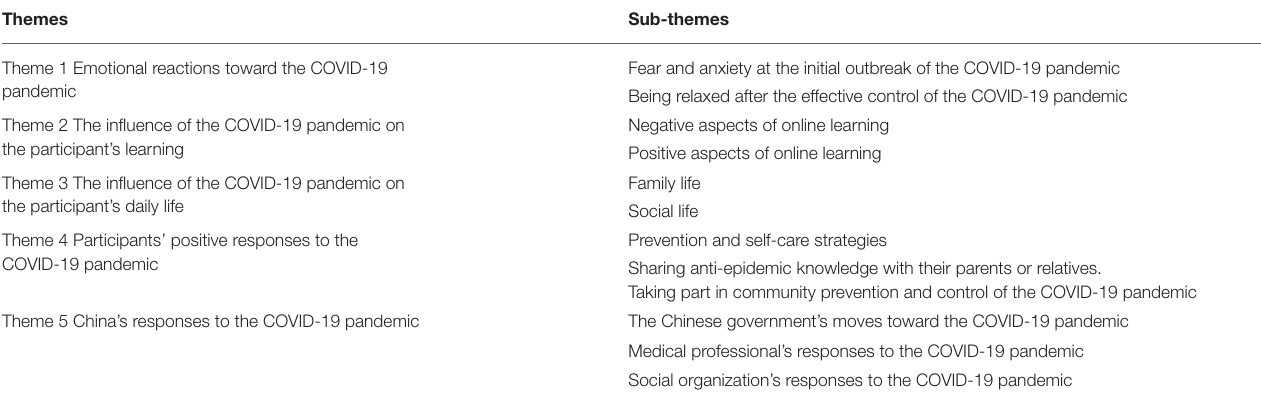
TABLE 2 | Results: five themes and 12 their sub-themes.